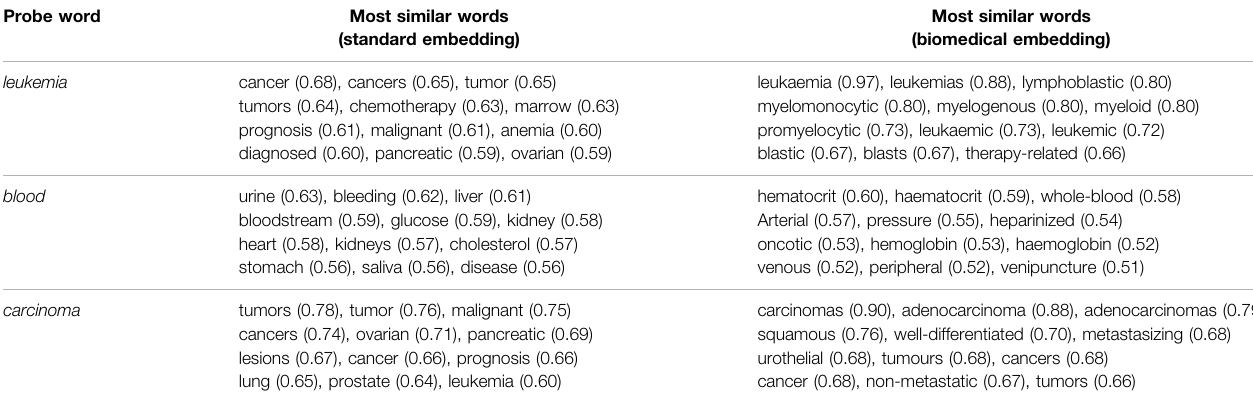
TABLE 1 | Illustrative comparison between standard and biomedical word embeddings. Probe word Most similar words (standard